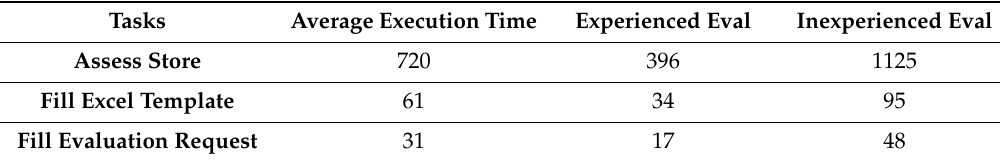
Table 3. Definition of non-functional measurements of each task. 532